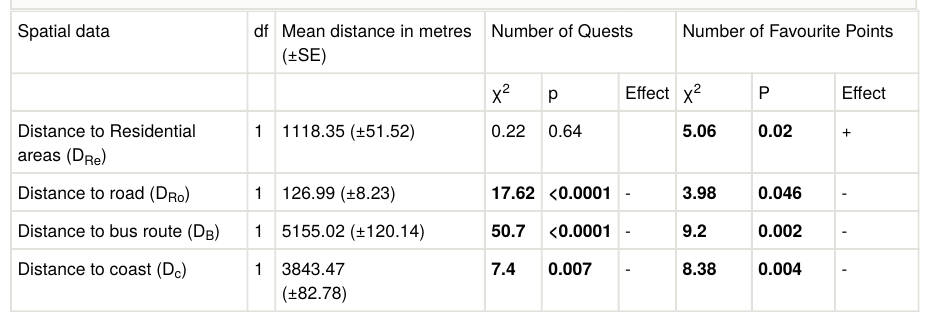
a χ test are shown.